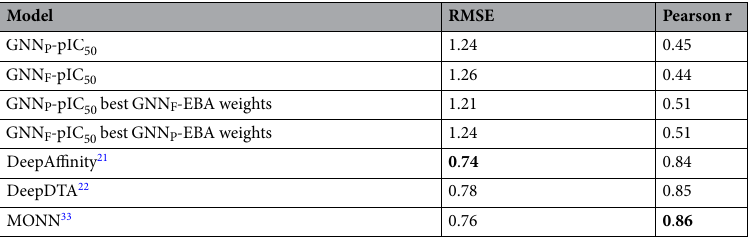
Table 9. Performance comparison of deep learning models in predicting pIC 50 . Our models were trained and tested on PDBbind2016 + DUD-E targets, whose IC 50 was curated from the PDBbind and ChEMBL repositories, respectively. DeepAffinity, DeepDTA, and MONN were trained and tested on BindingDB data. The top scores are given in bold.